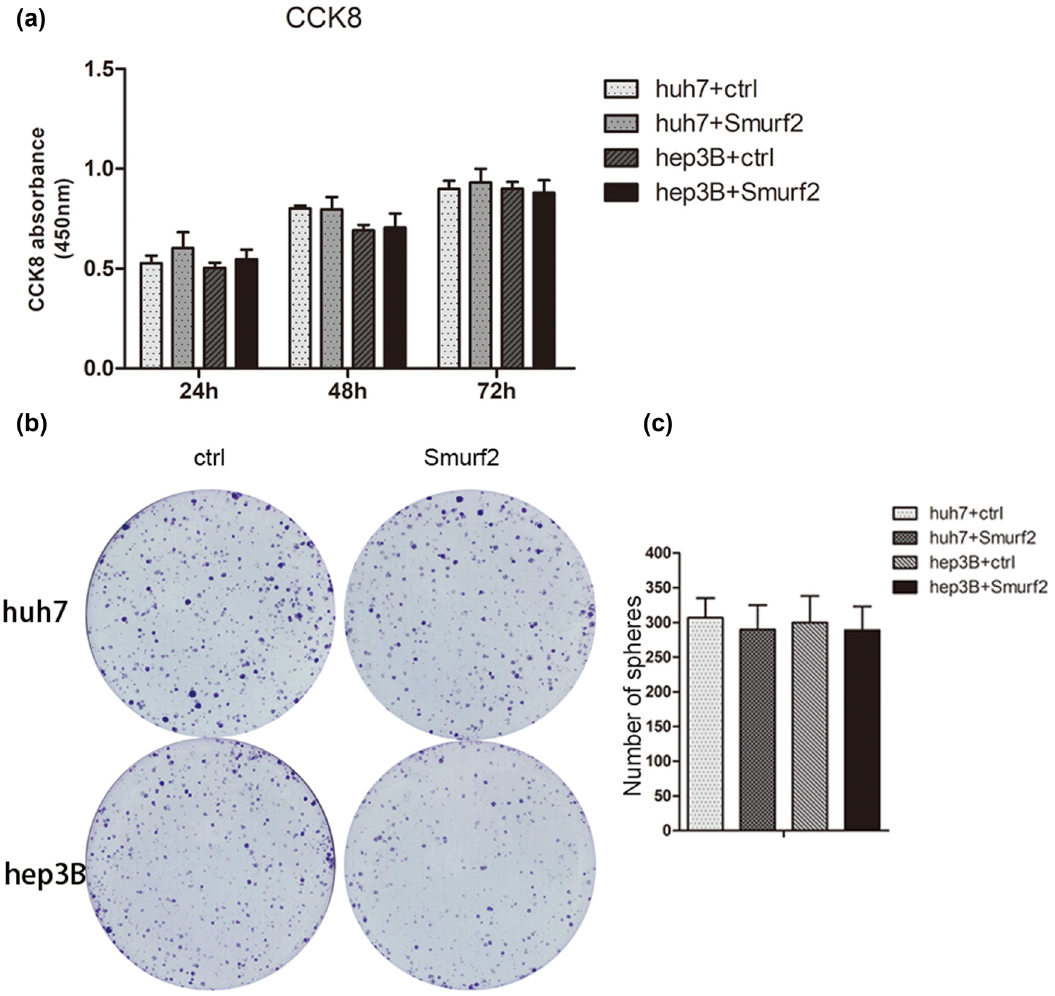
Figure 3: Smurf2 had no signi fi cant e ff ect on the proliferation of HCC cell lines. ( a ) Detection of the proliferation of Hep3B - Smurf2 and Huh7 - Smurf2 cells by CCK8 assay; * P < 0.05; ( b and c ) colony - forming assay of Hep3B - Smurf2 and Huh7 - Smurf2 cells; * P <